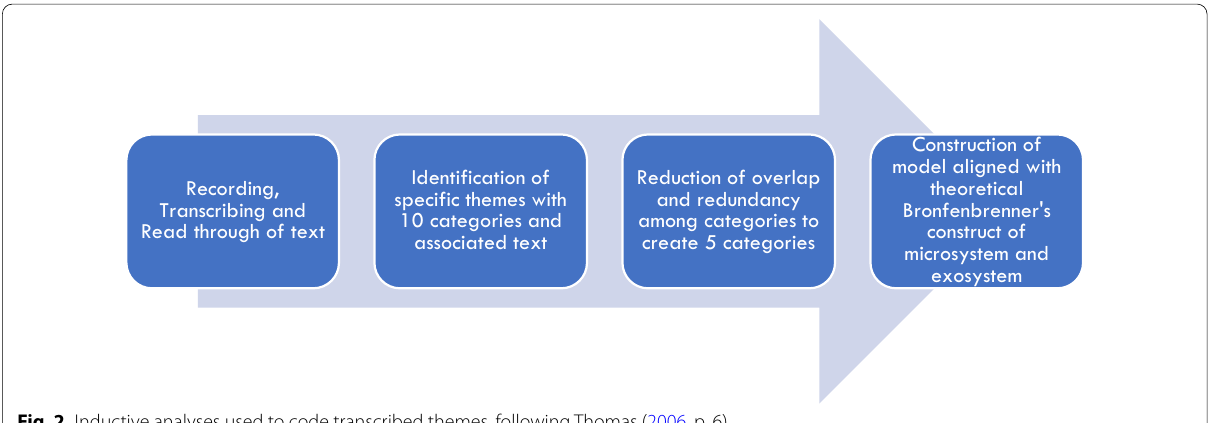
Fig. 2 Inductive analyses used to code transcribed themes, following Thomas (2006, p. 6)